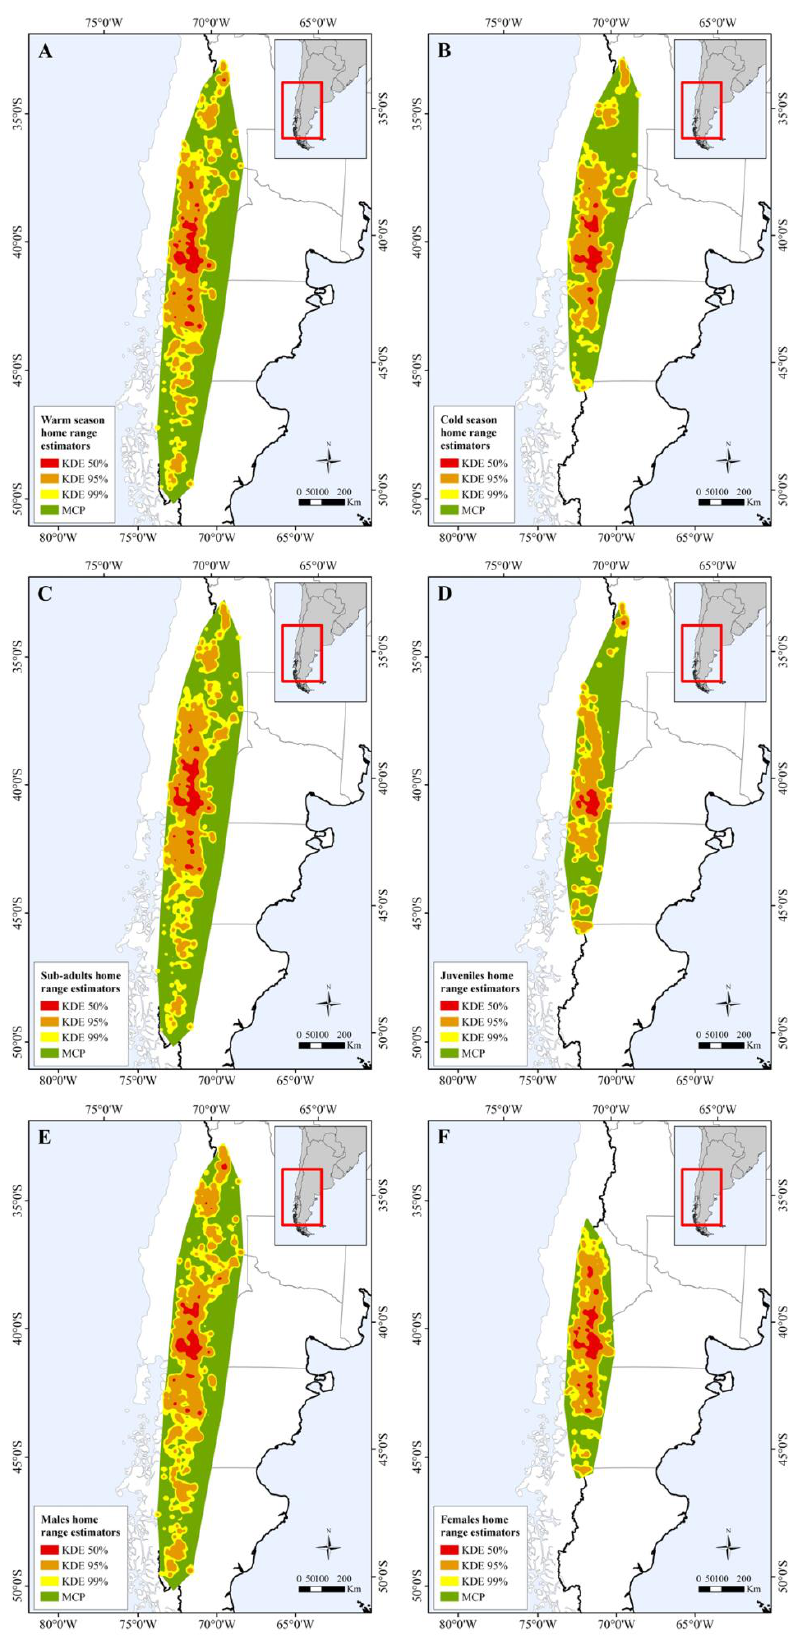
Figure 2. Map showing differences in home range size between: ( A ) warm and ( B ) cold seasons; ( C ) sub-adults and ( D ) juveniles; and ( E ) male and ( F ) female individuals.